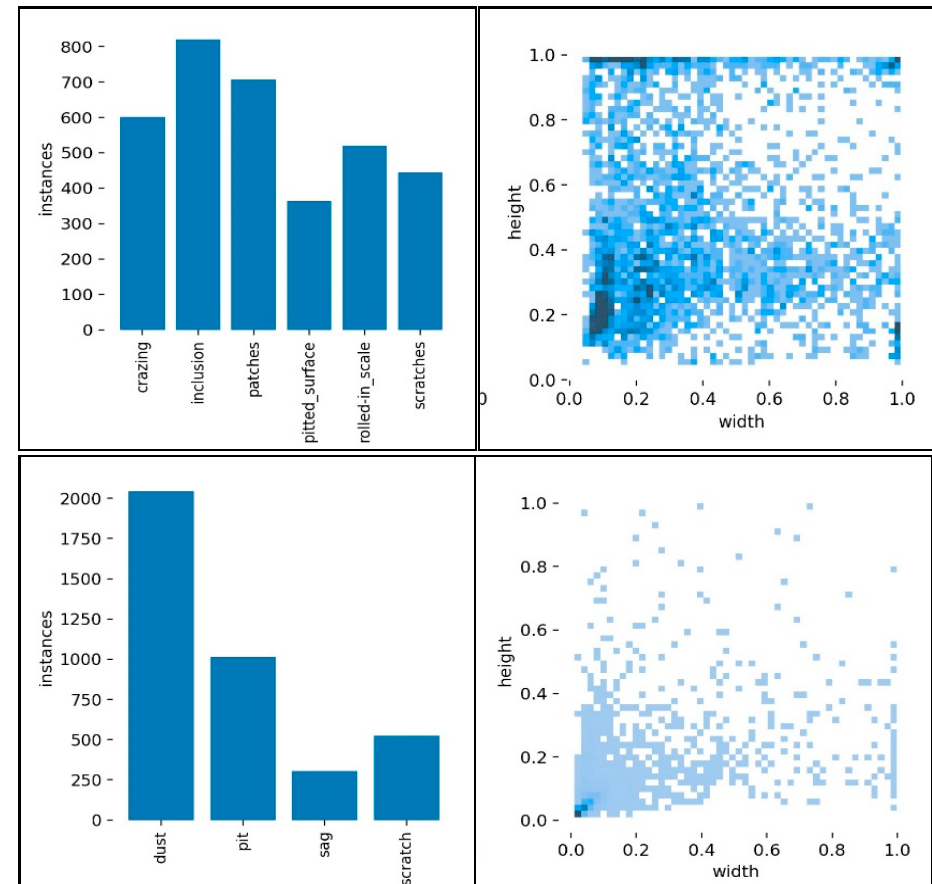
Figure 2. ( a ) NEU dataset sample statistics ( b ) Paint dataset sample statistics.